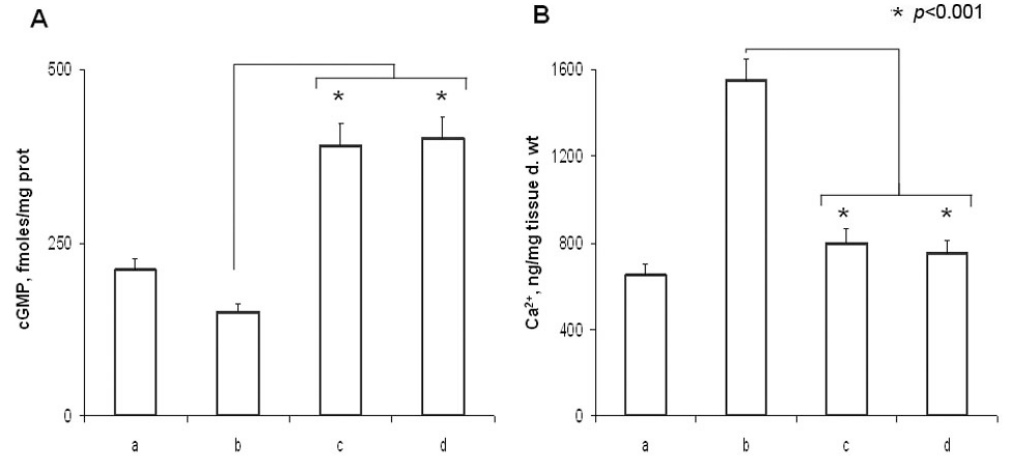
FIGURE 2. Tissue levels of cGMP (A) and calcium (B) in control hearts (a), hearts after OA challenge (b), and after OA challenge on perfusion with free (c) or immobilized (d) histaminase (4 IU/ml). Data are expressed as mean ± SEM of eight